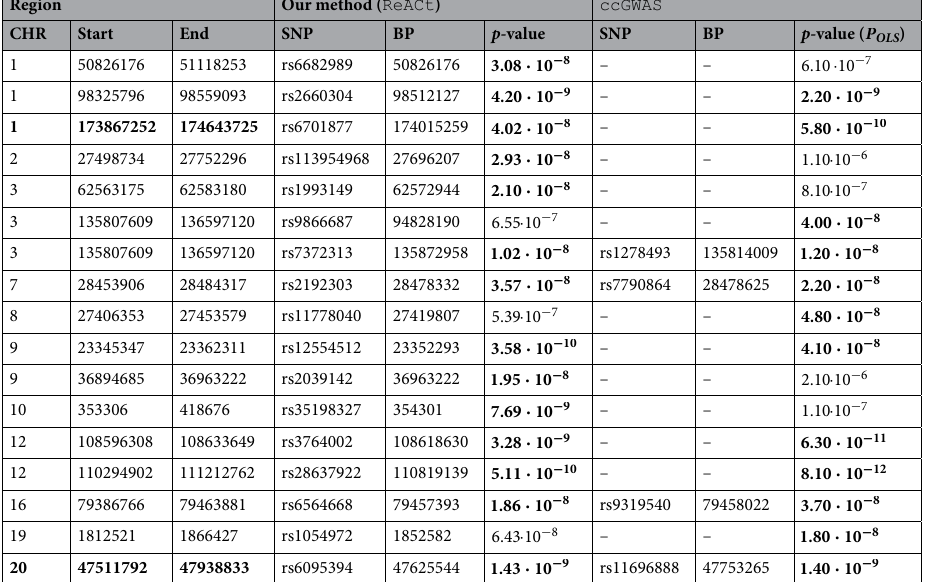
Table 4. Comparison of genomic regions showing significant divergent genetic effects between BD and SCZ as detected by ReACt and ccGWAS by Peyrot et al. 16 . We carried out cc-GWAS with ReACt using summary statistics of BD and SCZ and compared our results with the results from Peyrot et al. Only SNPs that are analyzed in both studies are included for the comparison. Genomic regions that are identified to show significant divergent genetic effects between BD and SCZ in either result are shown. CHR, Start and End are chromosomal and base-pair ranges for the region; SNP, BP and p -value (ordinary least squares p -values, P OLS , for ccGWAS by Peyrot et al.) are properties of the leading SNP (if the regions is reported genome-wide significant) or statistics for the matching SNP (if the region is not reported as genome-wide significant, but is detected by the other method); p -values in bold are leading SNPs that are reported genome-wide significant by each method; Regions with CHR, Start and End in bold are two loci that were also identified by the case-case GWAS using individual level data 34